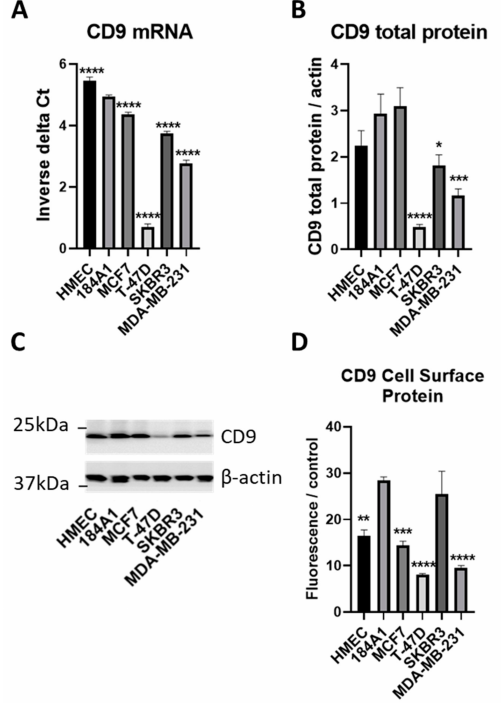
Figure 3. CD9 expression is decreased in non-tumorigenic and tumorigenic breast cell lines. ( A ). CD9 mRNA expression was measured using qPCR in a panel of non-tumorigenic and tumorigenic breast cell lines. Results are shown as inverse delta Ct. ( B ). CD9 total protein expression was assessed using SDS-PAGE and western blotting. Results expressed as CD9 total protein normalized to beta actin expression. ( C ). Representative western blot of CD9 total protein expression in the panel of breast cell lines. See Figure S2 for full western blotting images. ( D ). Flow cytometric analysis of CD9 cell surface protein expression in breast cancer cell lines compared to non-tumorigenic breast cells. Results shown as geometric mean fluorescence intensity of CD9 antibody normalized to geometric mean fluorescence intensity of IgG antibody control. n = 3; * p = 0.04, ** p = 0.002, *** p = 0.0008, **** p <